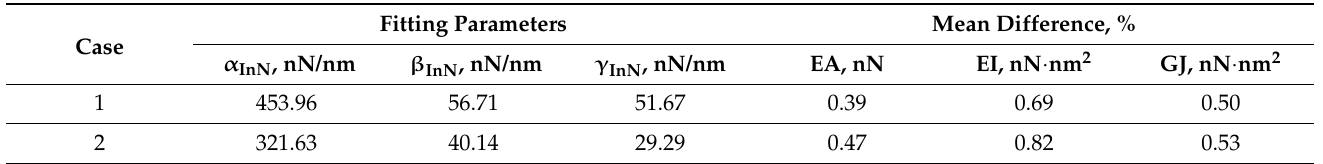
Table 5. Fitting parameters α InN , β InN and γ InN for SWInNNTs and mean difference between the EA, EI and GJ values evaluated with the aid of these parameters (Equations (30)–(32)) and the corresponding values acquired from the numerical simulation.